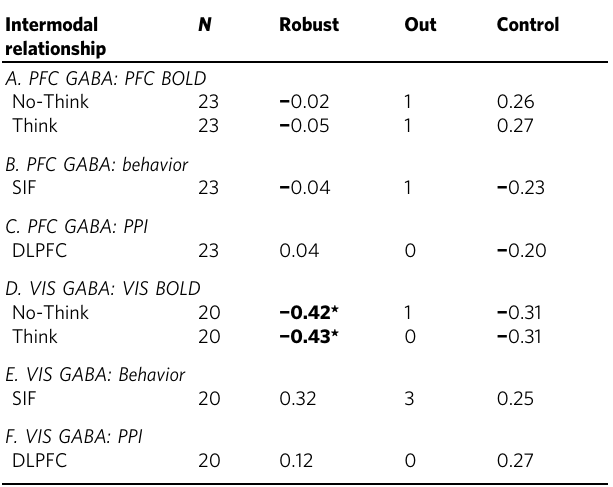
Table 2 Intermodal relationships of DLPFC and visual cortical GABA N Robust Out Intermodal relationship